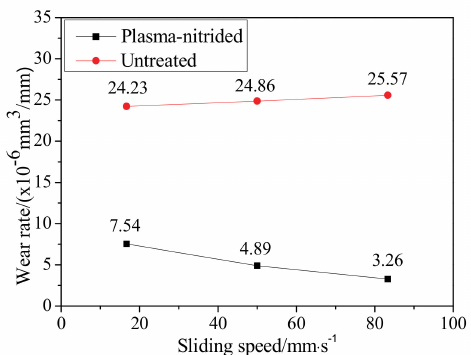
Figure 16. The wear rates of untreated specimens and plasma-nitrided specimens under di ff erent sliding speeds at the load of 100